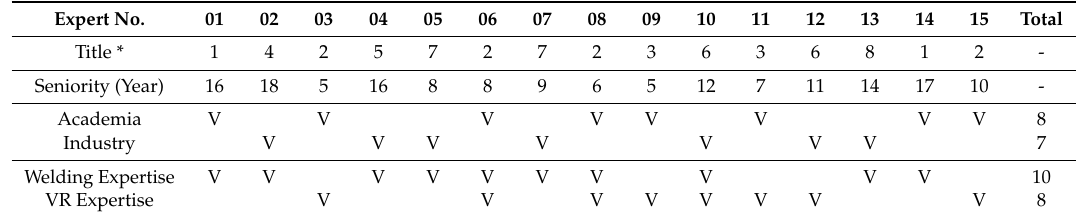
Table 2. Expert Background